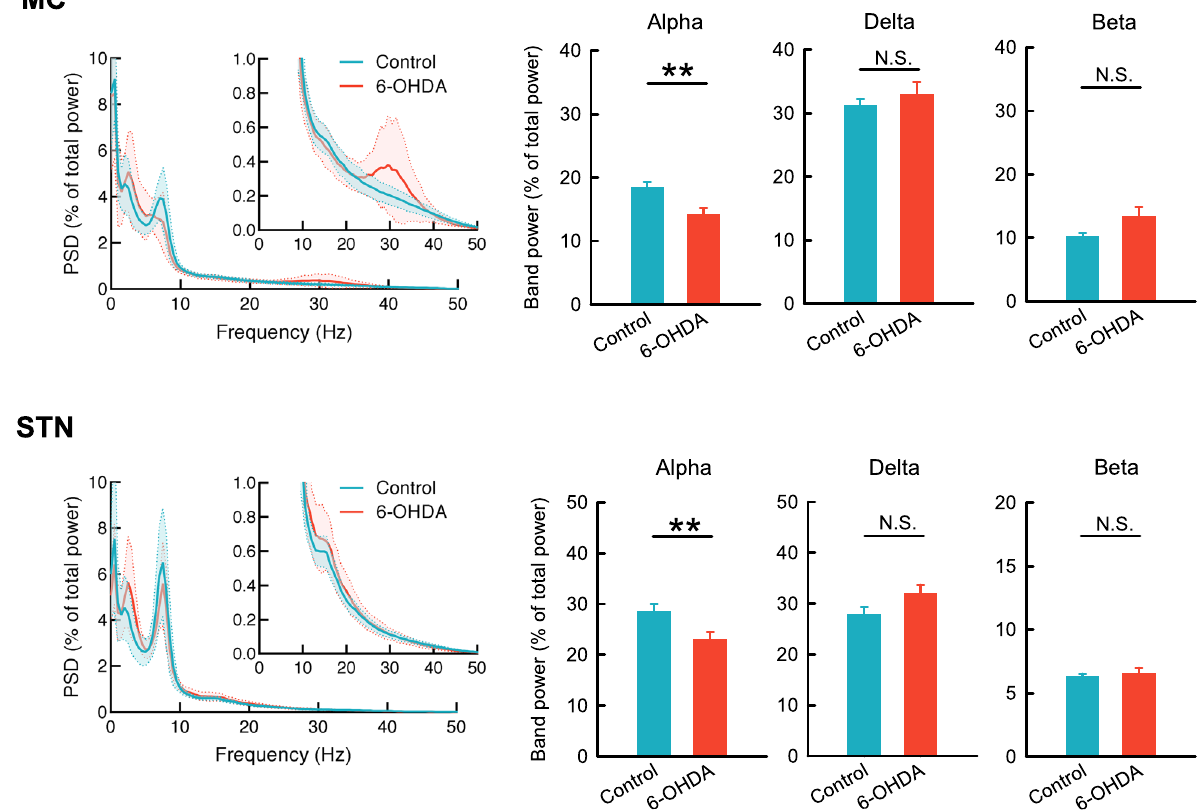
Fig. 1 The basic rhythms of MC and STN in control and parkinsonian rats. The average PSD spectra of 29 and 20 continuous 5-min LFP recordings from 10 control (blue) and 11 parkinsonian (6-OHDA, red) rats, respectively. The open fi eld test (OFT) reveals a signi fi cantly higher peak in the α band (7 – 10 Hz) in control than in parkinsonian rats in both MC ( a ) and STN ( b ). Meanwhile, there is a lower δ band (1 – 4 Hz) power in both MC and STN in control than in parkinsonian rats, although the differences are statistically insigni fi cant. In contrast, a peak oscillation in β band (20 – 40 Hz) in parkinsonian but not in control rats is noted only in MC. PSD spectra were presented as mean (solid curves) ± standard deviation (shaded areas). Data in the bar plots were presented as mean ± standard error of mean (S.E.M.). Data were analyzed with Mann – Whitney U tests. ** p < 0.01, N.S., nonsigni fi